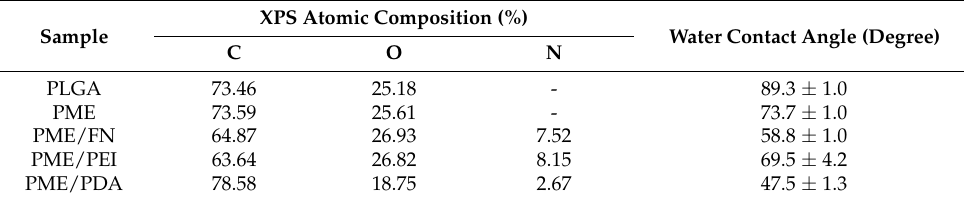
Table 1. Surface chemical composition and water contact angle of the composite films.